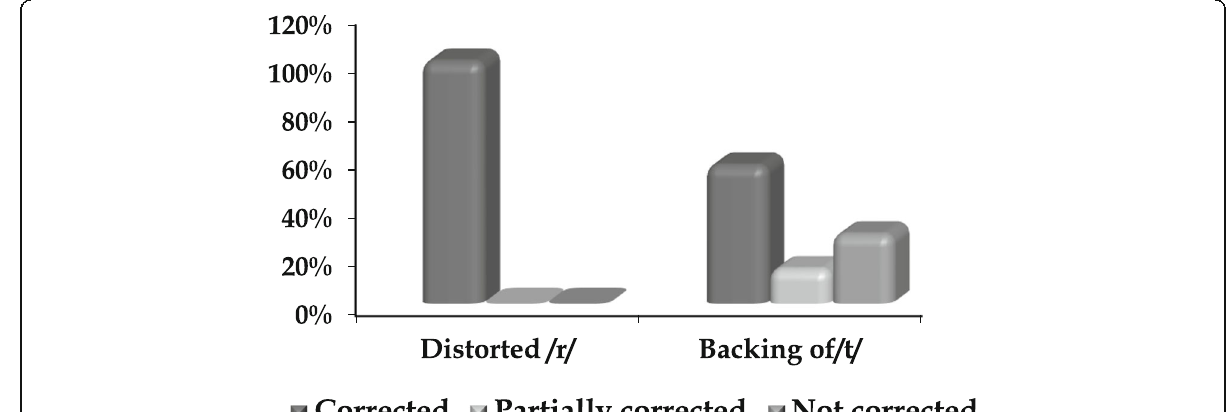
Fig. 6 Distribution of the studied cases after intervention ( n =